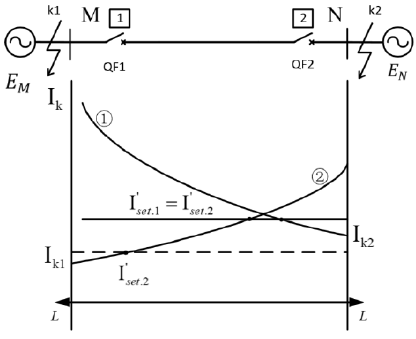
Figure 2: Short-circuit current curve of bilateral power supply